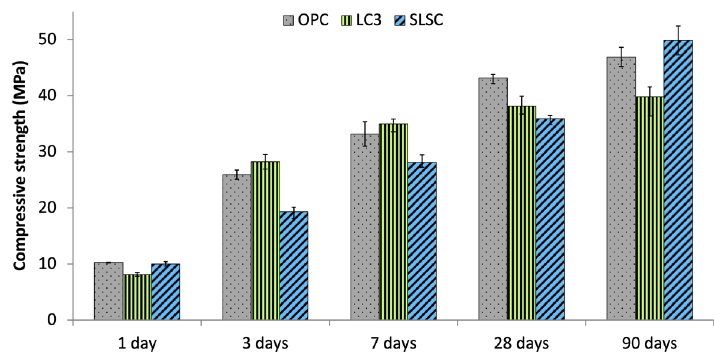
Figure 1. Cement mortar compressive strength plot for OPC, LC 3 and